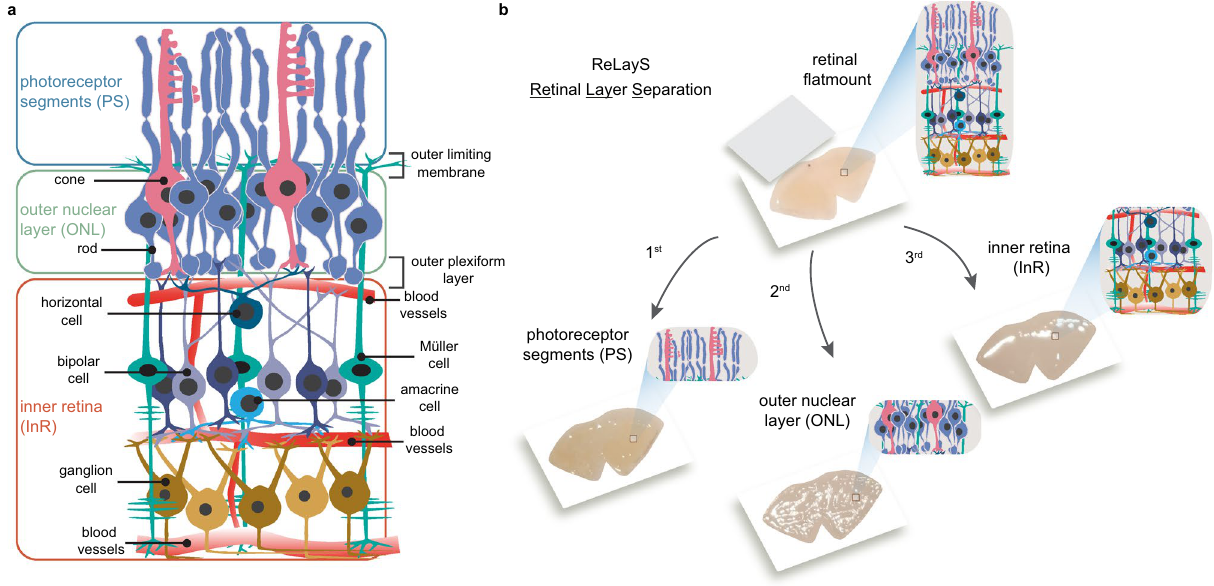
Figure 1. Scheme of the ReLayS method. ( a ) Schematic representation of the retina showing the localization of the seven major cell types in the retina and the two breaking points for ReLayS - the outer limiting membrane and the outer plexiform layer. ( b ) Schematic representation and representative photographs of photoreceptor segments (PS), outer nuclear layer (ONL), and inner retina (InR) as they are separated by ReLayS. Images were created in Adobe Illustrator